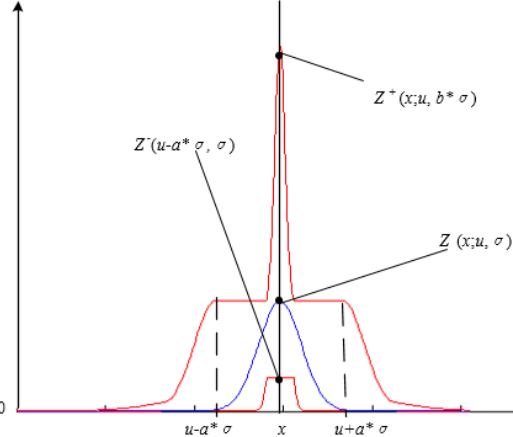
Figure 4. Type-2 fuzzy model with uncertain mean and standard deviation.